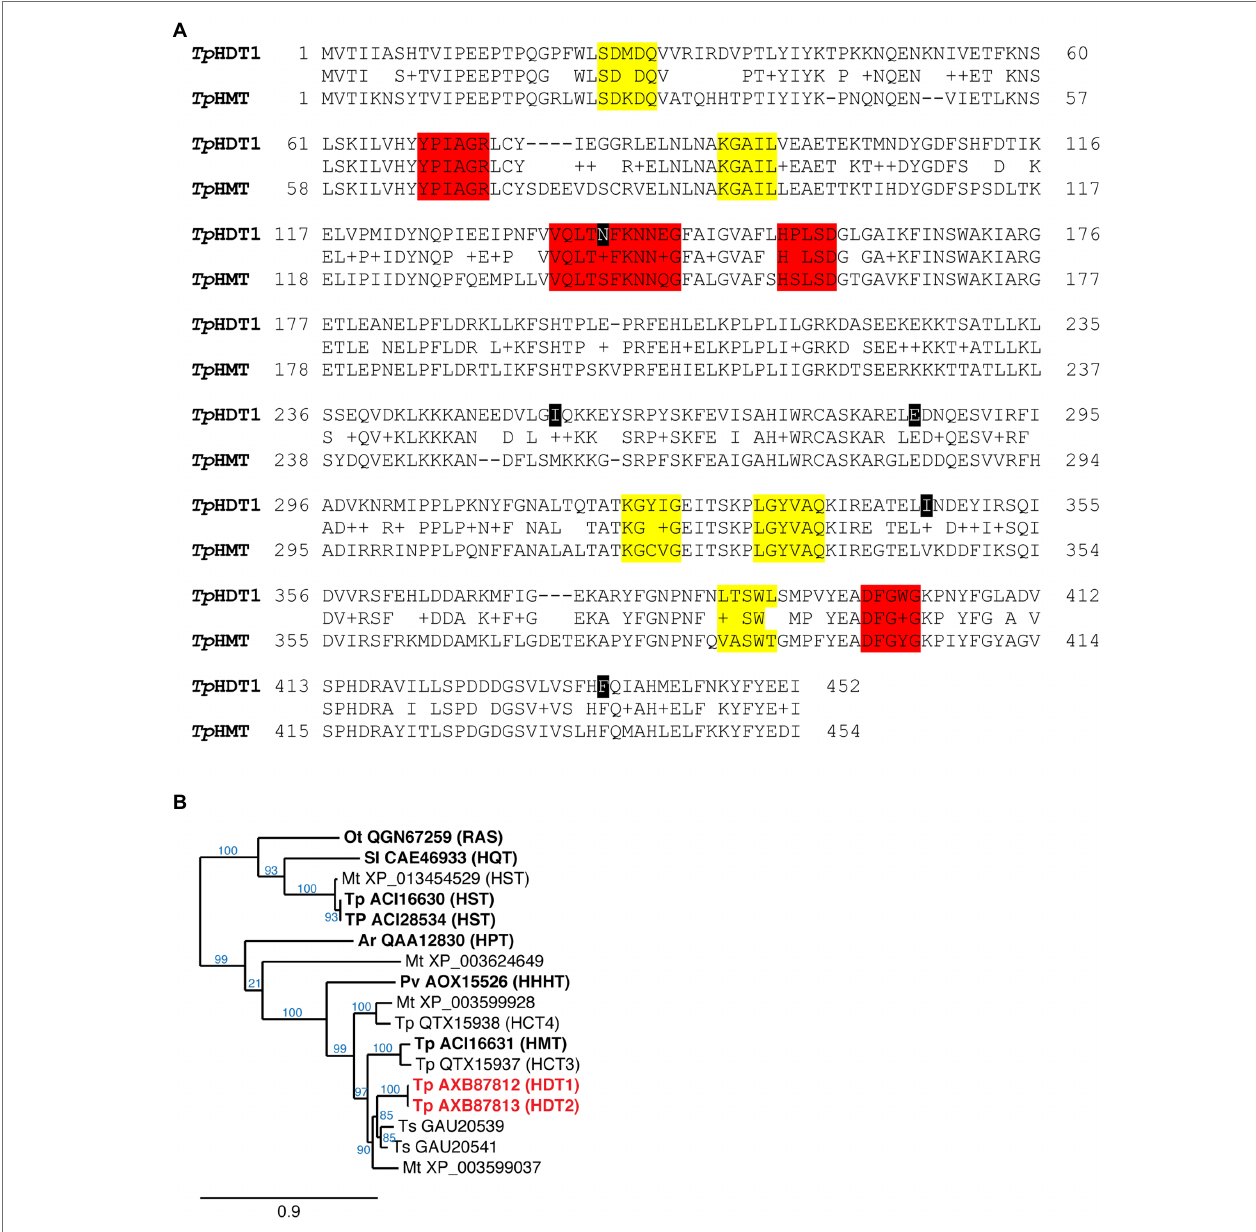
FIGURE 3 | (A) Amino acid sequence comparison of red clover HDT1 and HMT. Gaps are shown with a “-” and conservative substitutions are shown with a “+.” Amino acids that differ between HDT1 and HDT2 are marked in black (K140N, V255I, K285E, V346I, and L436F). Motifs conserved among all BAHD acyltransferases are highlighted in red while motifs specific to the hydroxycinnamoyl transferase-containing Clade Vb are highlighted in yellow (D'Auria, 2006; Tuominen et al., 2011). (B) Phylogenetic relationship of red clover HDT to several other Clade Vb BAHD acyltransferases, which contains hydroxycinnamoyl-CoA hydroxycinnamoyl transferases. Dendrogram was generated with BAHD hydroxycinnamoyl-CoA hydroxycinnamoyl transferase amino acid sequences as described in Materials and Methods. For each protein sequence, the GenBank identifier is provided and species from which the sequences are derived are designated as follows: Ar, Actaea racemosa ; Mt., Medicago truncatula ; Ot, Ocimum tenuiflorum ; Pv, Phaseolus vulgaris ; Sl, Solanum lycopersicum ; Tp, Trifolium pratense ; and Ts, Trifolium subterraneum . HDT1 and 2 are highlighted in red. Transferases that have been biochemically characterized are in bold text. Enzyme activities (in parentheses) are hydroxycinnamoyl- CoA hydroxycinnamoyl transferases with the following acceptor substrates: HDT, L-DOPA/L-Tyr; HMT, malate; HHHT, tetrahydroxyhexanedioic acid; HPT, piscidic acid; RAS (rosmarinic acid synthase), hydroxyphenyllactate; HST, shikimic acid; and HQT, quinic acid. Branch support values (%) are shown in